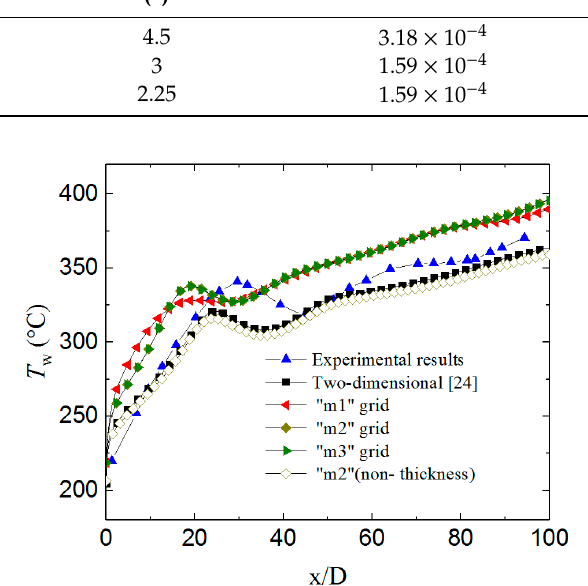
Figure 4. Grid independence analysis and model validation.